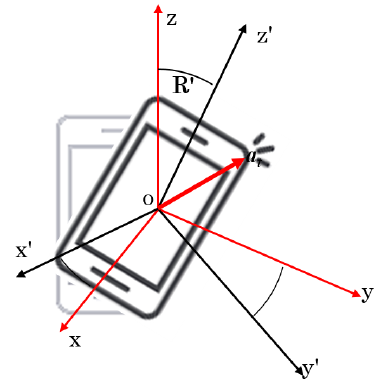
Figure 3. An example of sensor orientation inconsistency: within and among